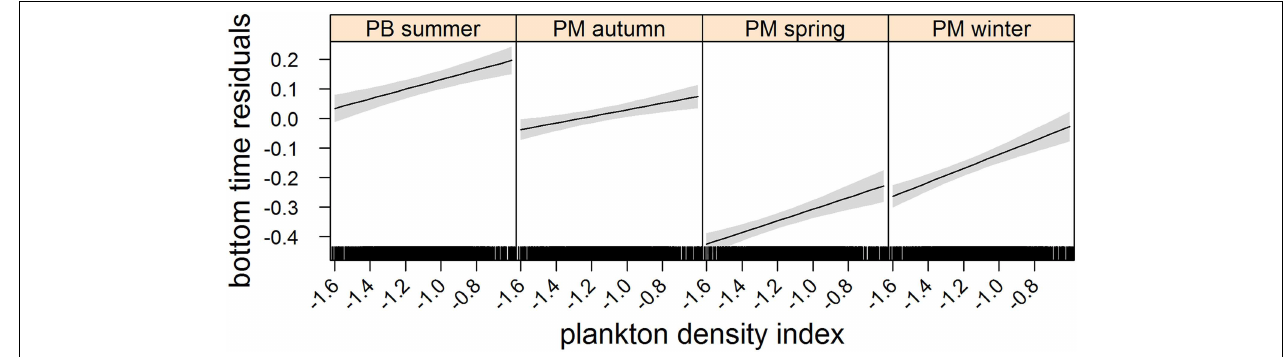
FIGURE 3 | Effects plot of the relationship between plankton densities encountered by seals (i.e., PDI) and their dive effort (i.e., bottom time residuals) according to season from our mixed model analysis. Shaded area indicates the confidence interval.